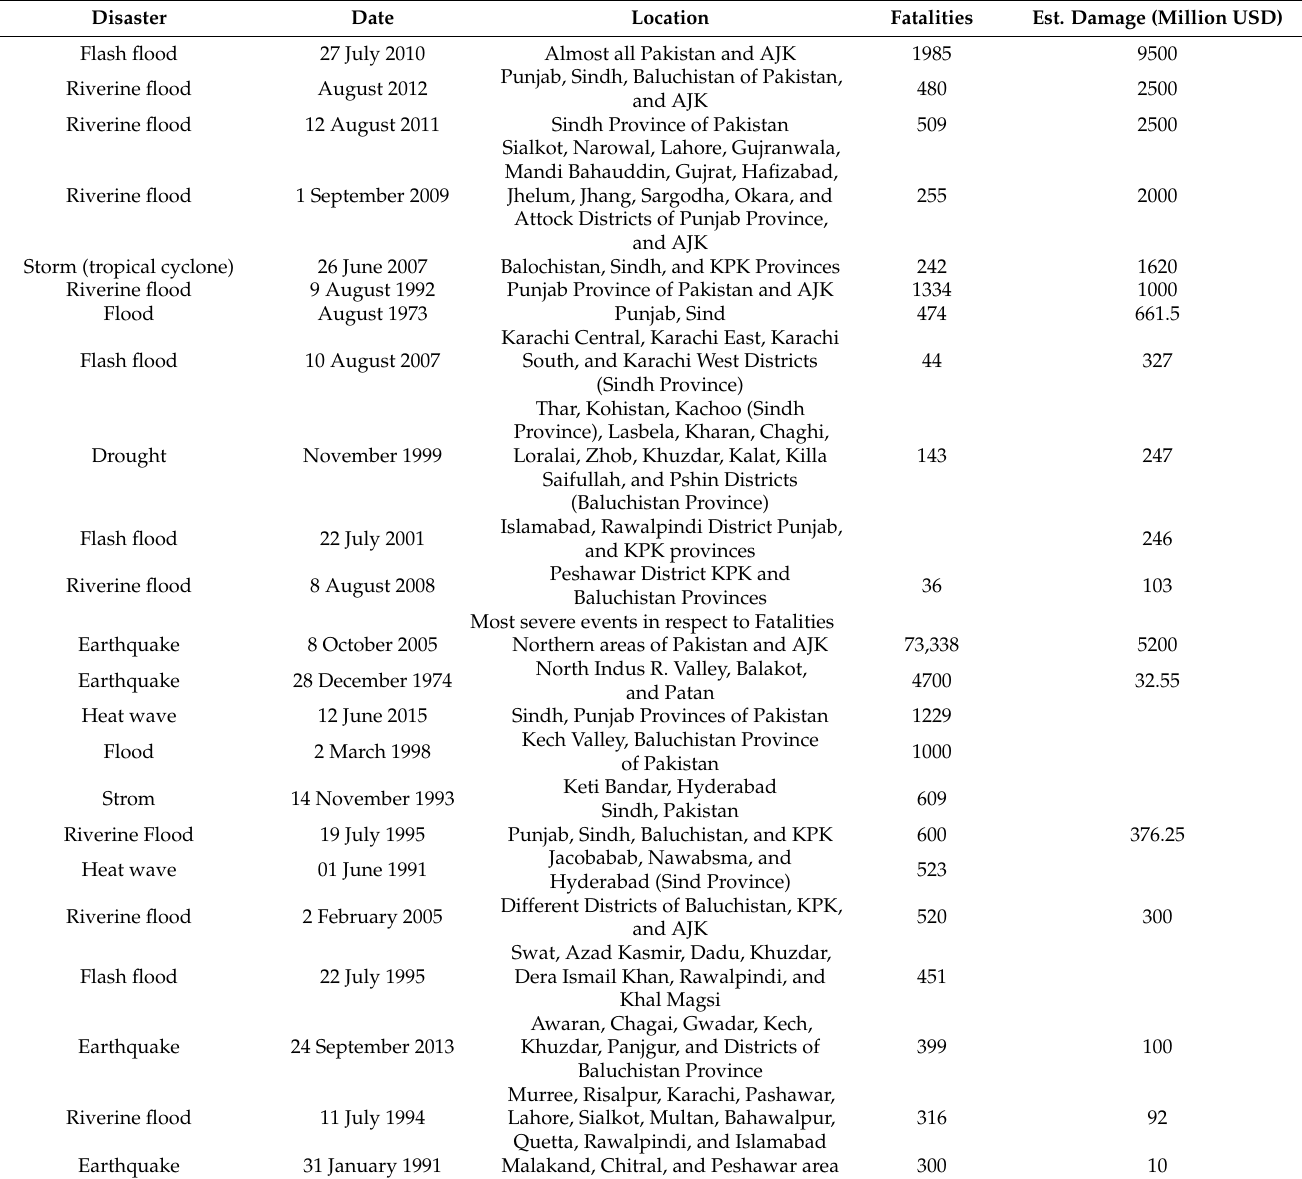
Table 1. Most severe events with respect to economic loss and fatalities in Pakistan between 1970 and